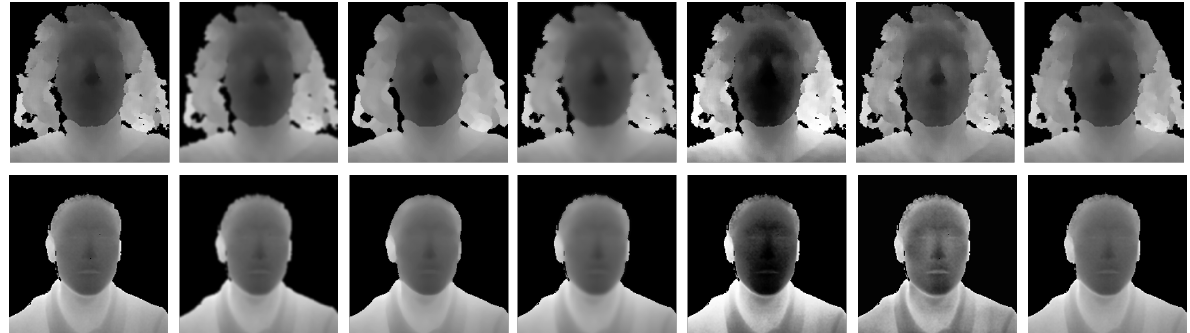
Figure 3. The sample images taken from Biwi [22] (first row) and Lock3d [21] (last row) showing the visual results of the pre-processing steps. On the left, the original depth image is reported. Then, we show the results of the following operations: gaussian blur, median blur, bilateral filtering, histogram equalization, Contrast-Limited Adaptive Histogram Equalization (CLAHE), and hole filling. The images are converted to 8-bit format for